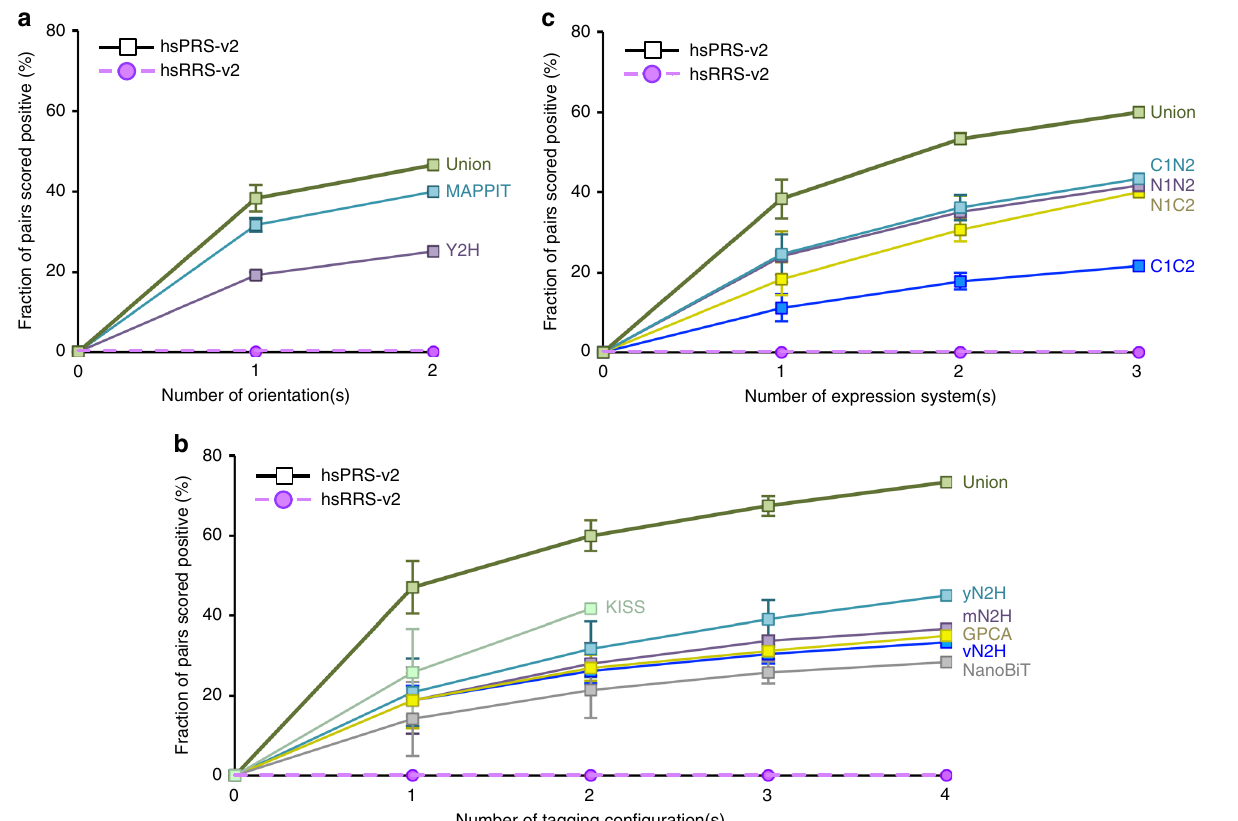
Fig. 5 Impact of permuting assay parameters on binary PPI detection. a – c PPIs detected by permuting ( a ) protein orientations in Y2H and MAPPIT, ( b ) tagging con fi gurations in KISS (only two versions tested), NanoBiT, GPCA, mN2H, yN2H and vN2H, and ( c ) protein expression environments in N2H. Error bars in ( a - c ) indicate standard